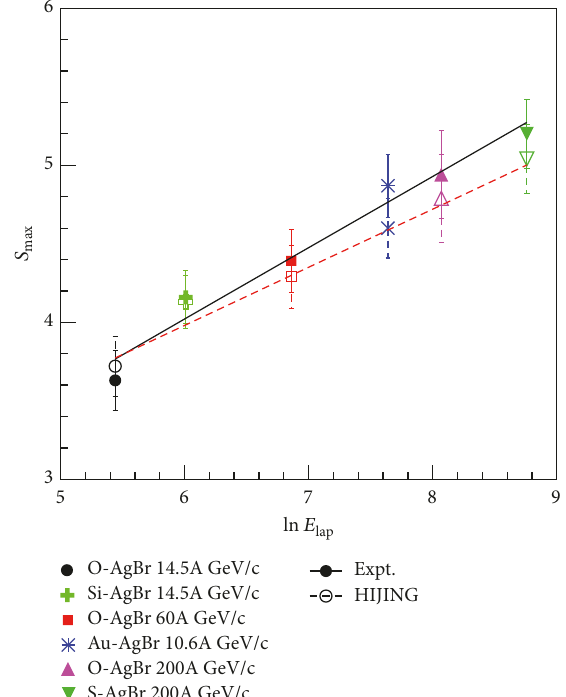
Figure 2: Variations of 𝑆 max with ln 𝐸 total for the experimental and HIJING